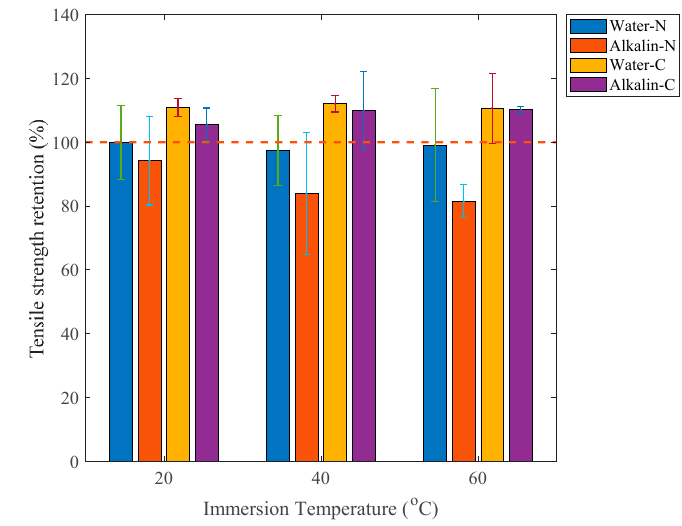
Figure 12. Tensile strength of: ( a ) Naked plate immersed in water; ( b ) Naked plate immersed in alkaline solution; ( c ) Coated plate immersed in water; ( d ) Coated plate immersed in alkaline solution.